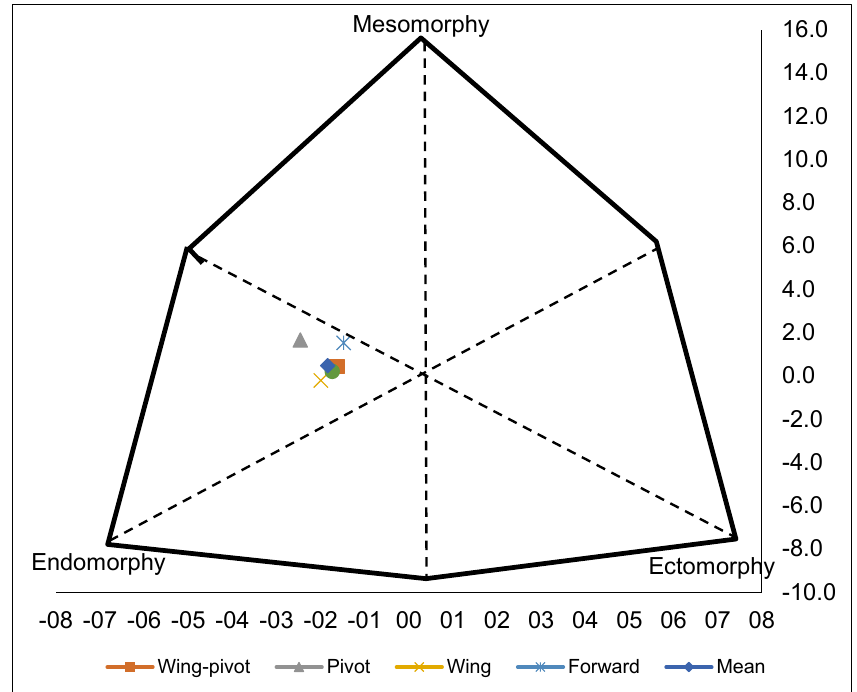
Figure 1. Representation of the somatotype.